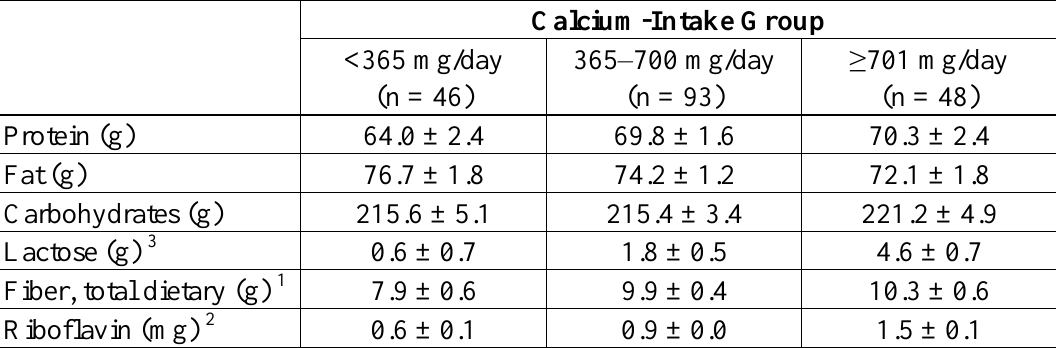
Table 3. Dietary intake of participants (Mean and SD) by calcium-intake groups adjusted for energy, age and